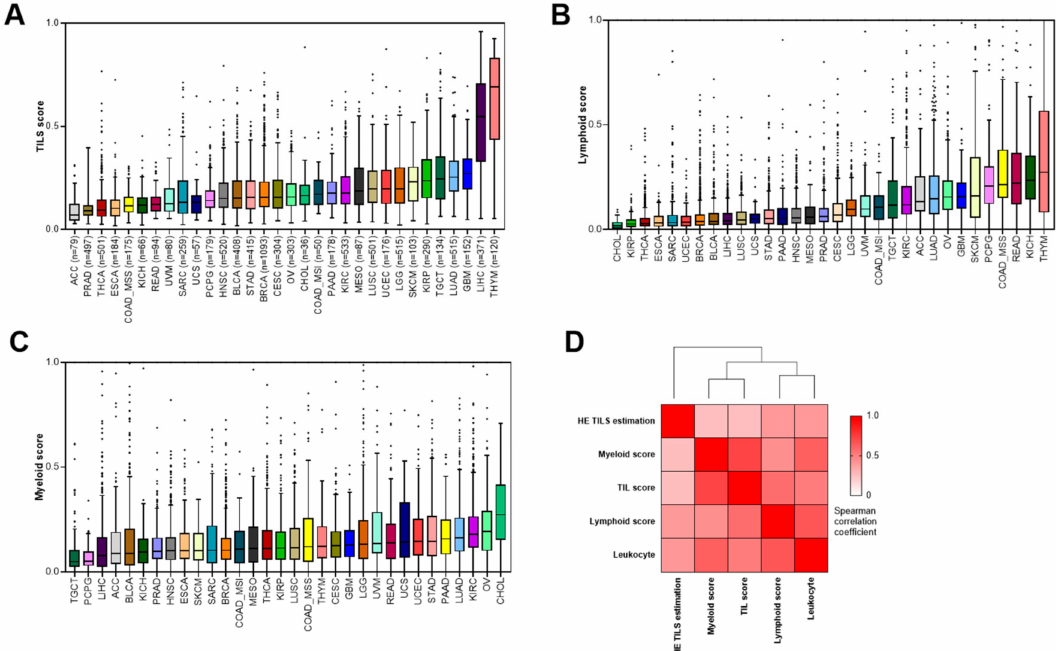
Figure 1. Evaluation of the tumor-infiltrating lymphocyte (TIL), lymphoid, and myeloid scores in the Pan-Cancer TCGA cohort. ( A – C ): Boxplots representing the distribution of the TIL ( A ), lymphoid ( B ), and myeloid ( C ) scores normalized between 0 and 1 according to tumor type for TCGA cohorts; for each score, tumor types are ordered by corresponding median values. ( D ): Spearman correlation matrix estimated for leukocyte, lymphoid, myeloid, TIL, and H&E TIL scores. Correlations were computed across all cancer types. H&E: hematoxylin and